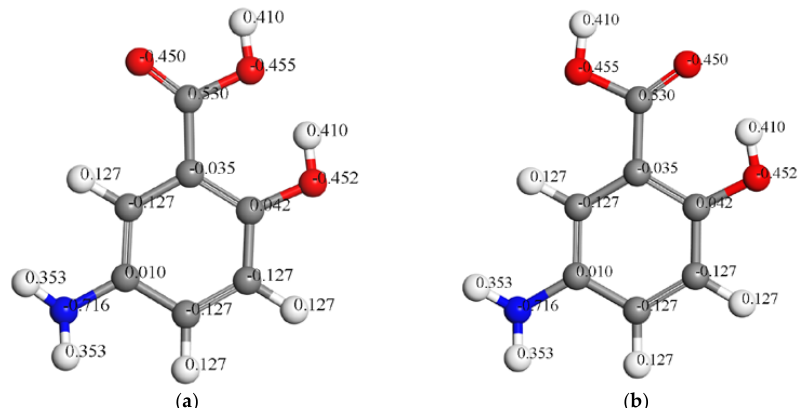
Figure 2. The optimized structures of the conformers of 5-ASA F1 ( a ) and F2 ( b ). Atomic charges calculated by the force field (FF) are shown. The C, N, O, and H atoms are in gray, blue, red, and white colors. This color pattern is maintained in the rest of the figures of this work.